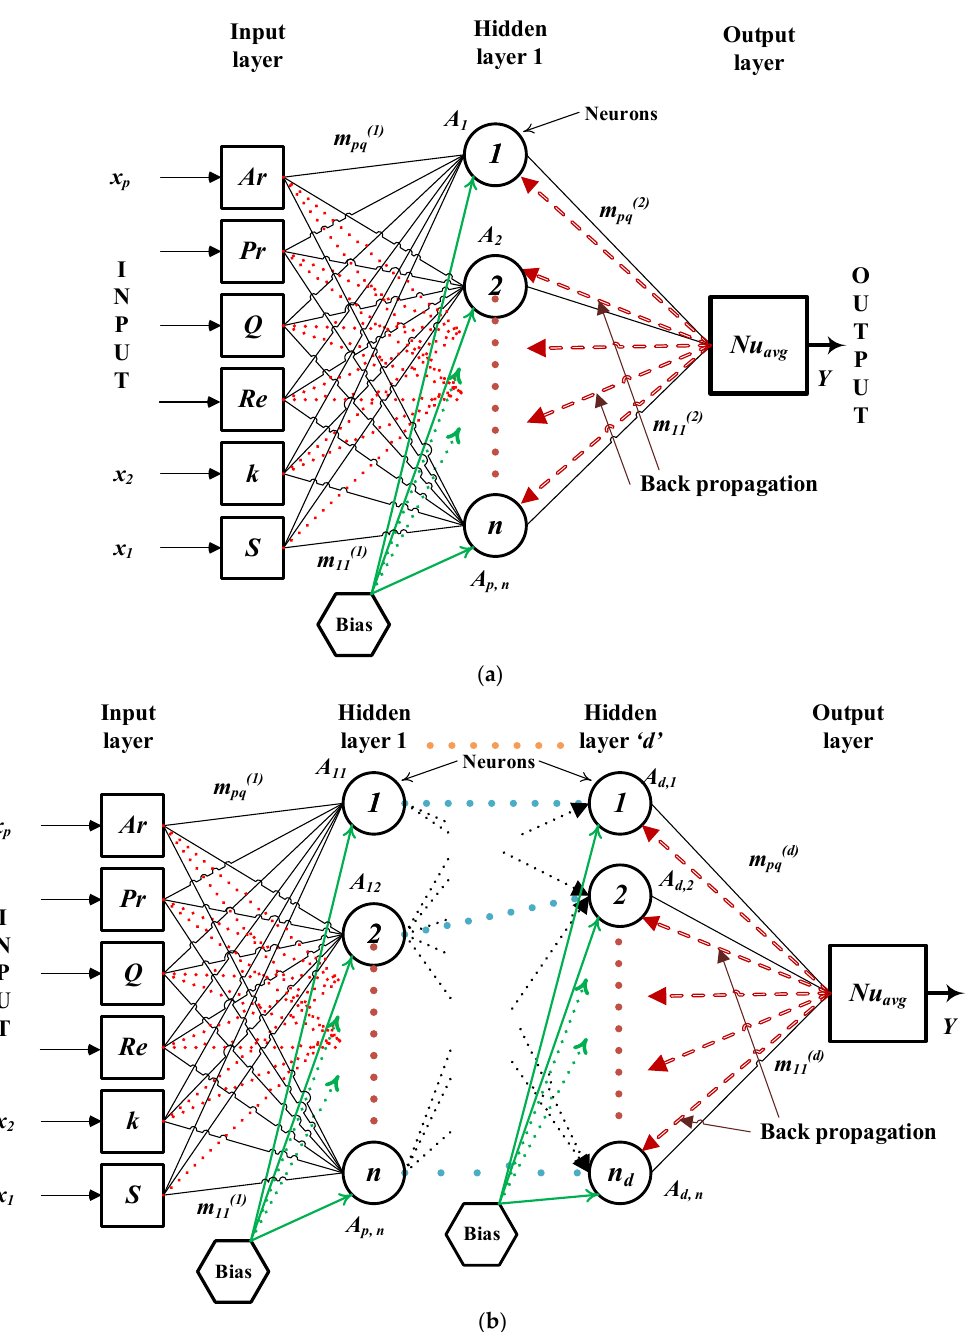
Figure 2. ( a ) Single hidden layer NN (NN 1 ) tested for the different number of neurons ( b ) Deep hidden layer NN (NN D ) tested for the different number of neurons and deep hidden layers ‘ d ’.